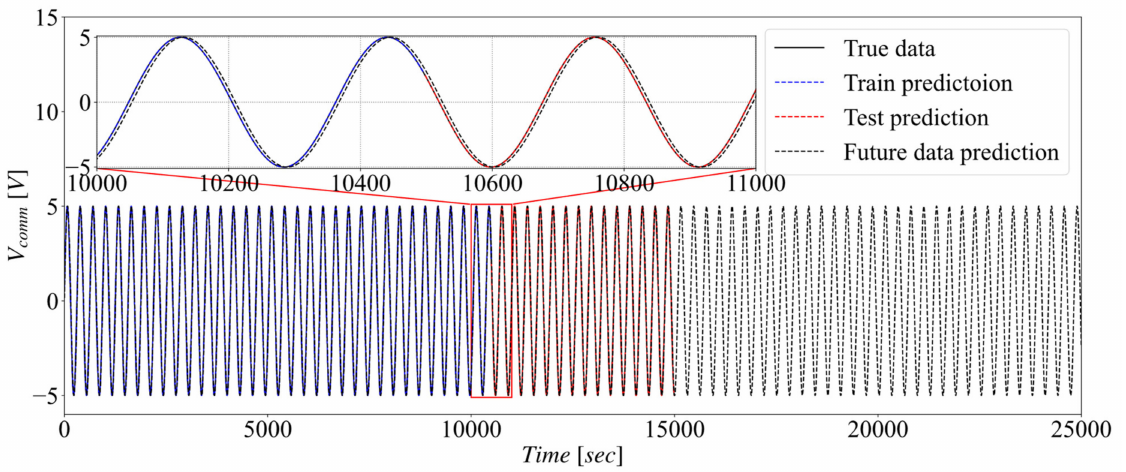
Figure 9. Prediction of voltage input